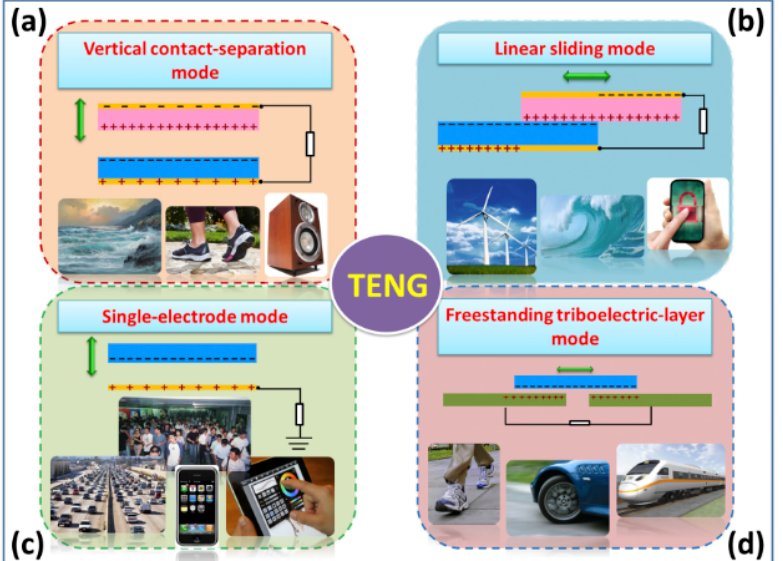
Figure 1. Several potential applications of TENGs using different operational modes: ( a ) vertical contact-separation, ( b ) linear sliding, ( c ) single-electrode, and ( d ) freestanding triboelectric-layer. Reprinted with permission from [72]. Copyright 2014, Royal Society of Chemistry.